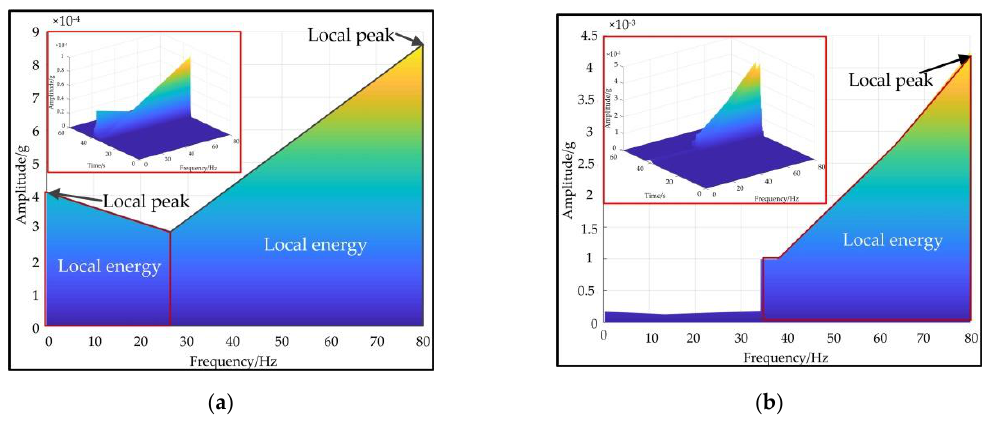
Figure 18. ( a ) Front view of the time – frequency spectrum (sensor No. 2, Segment 1). ( b ) Front view of the time – frequency spectrum (sensor No. 2, Segment 2).